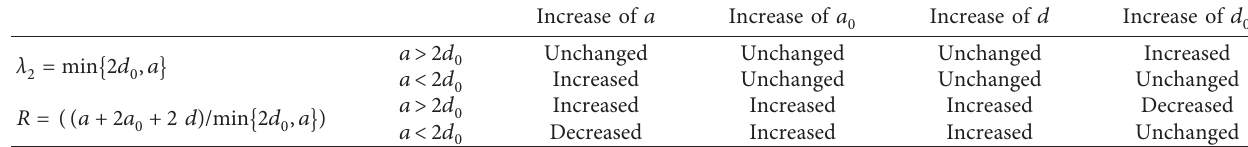
, d, and d of Network I when N is 0 0